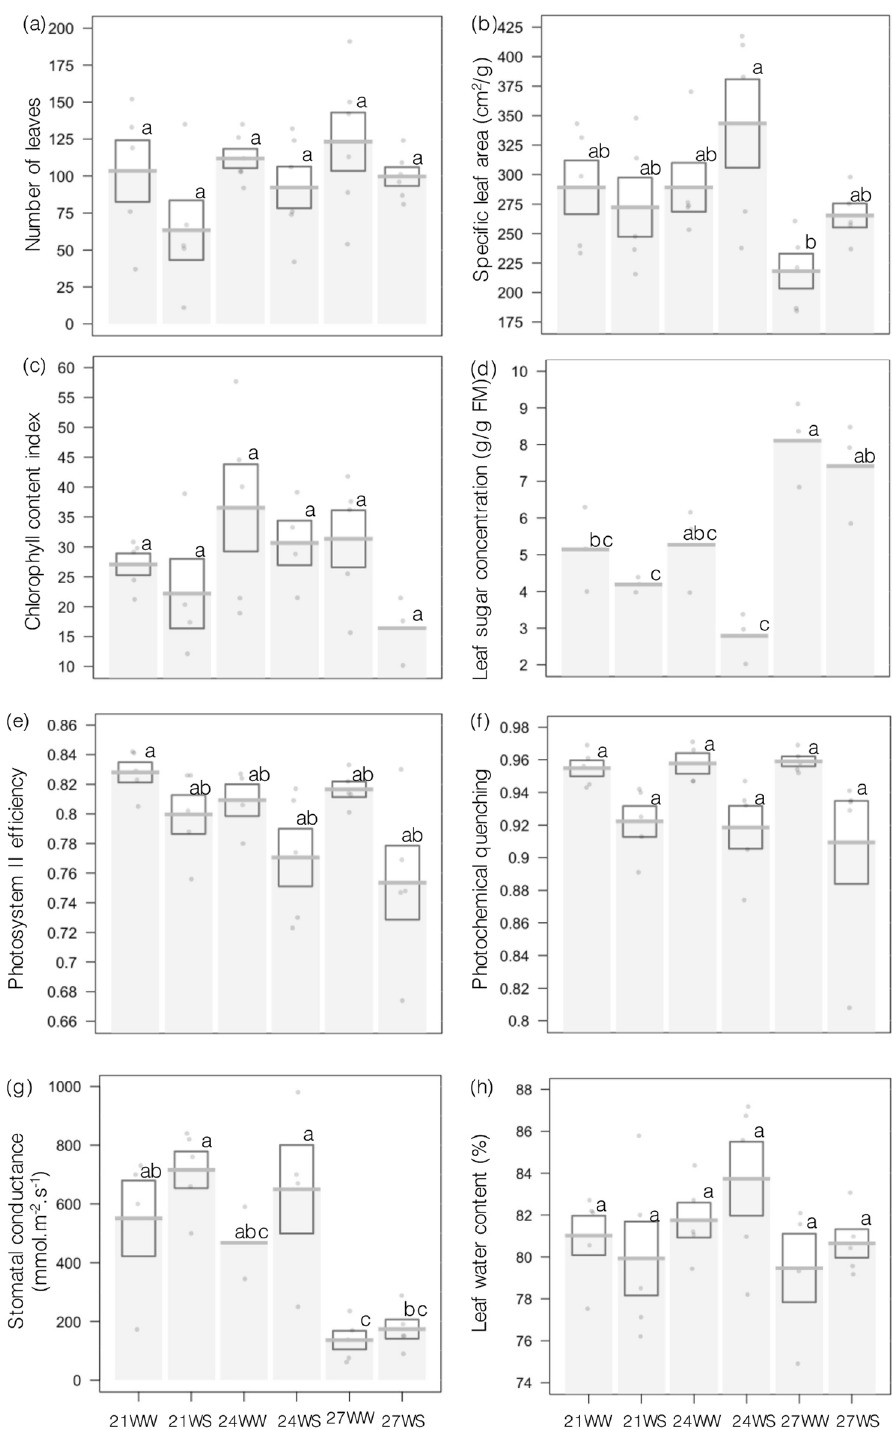
Figure 1. Effects of increasing temperatures and water stress on vegetative and physiological parameters of Impatiens glandulifera plants 2 weeks after beginning treatment. ( a ) Number of leaves, ( b ) specific leaf area, ( c ) chlorophyll content index, ( d ) leaf sugar concentration, ( e ) photosystem II efficiency, ( f ) photochemical quenching, ( g ) stomatal conductance and ( h ) leaf water content. N = 5 per treatment, except for leaf sugar content, with N = 3. Data are presented as means ± standard errors (SE) as barplots, with individual data points shown in gray. Treatments followed by different letters are significantly different at p < 0.05 21, 21 °C; 24, 24 °C; 27, 27 °C; WS, water-stressed; WW, well-watered. 21WW = control.